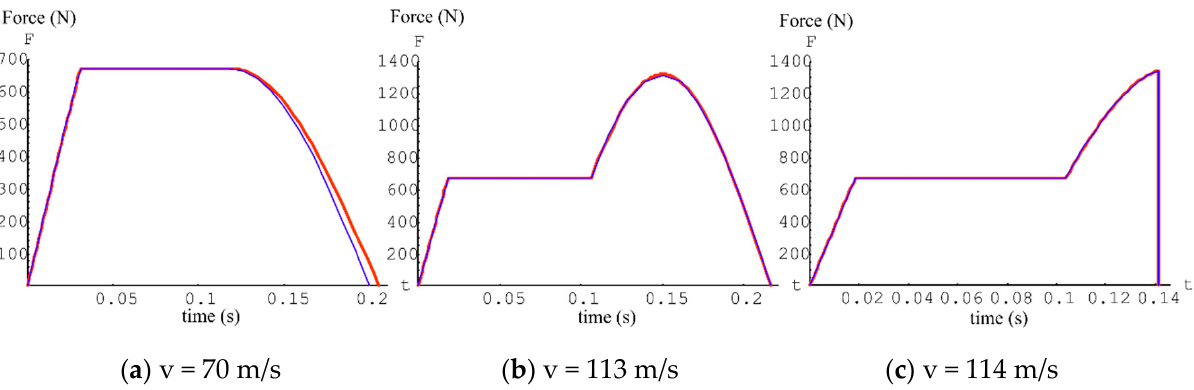
Figure 11. Forced responses at various initial velocities (v = 70 m/s, 113 m/s, 114 m/s). Number of segments = 1000, red line: approximate solution, blue line: exact solution.